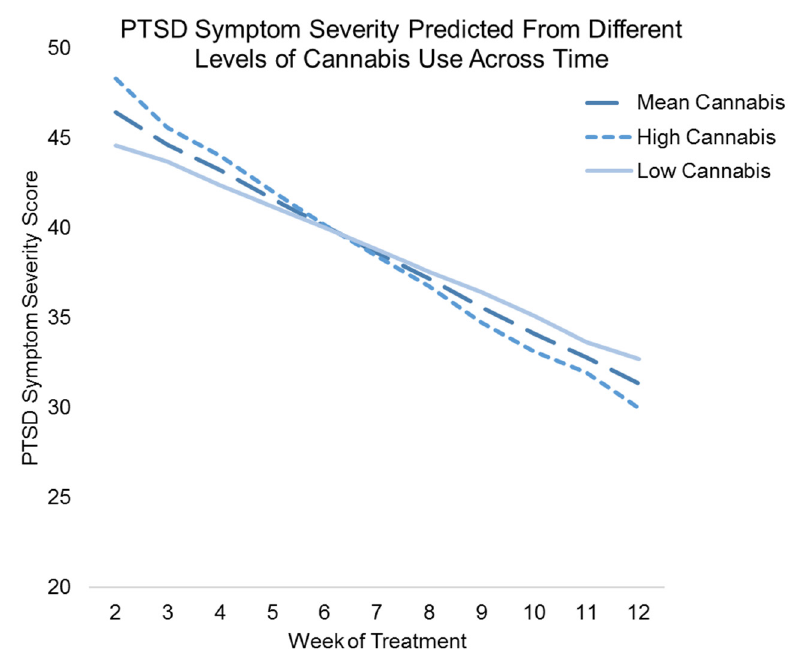
Figure 1. Figure showing the adjusted results of weekly lagged cannabis use and weekly lagged cannabis use x time, predicting weekly PTSD symptom severity scores. The x -axis represents the time from week 2 of treatment to week 12 of treatment (week 1 is not represented because the independent variable is lagged one time-point), while the y -axis represents the predicted score on the PTSD symptom severity measure. Results show a crossover effect, whereby higher weekly lagged cannabis use was associated with greater weekly PTSD symptom severity early in treatment, but lower weekly PTSD symptom severity later in